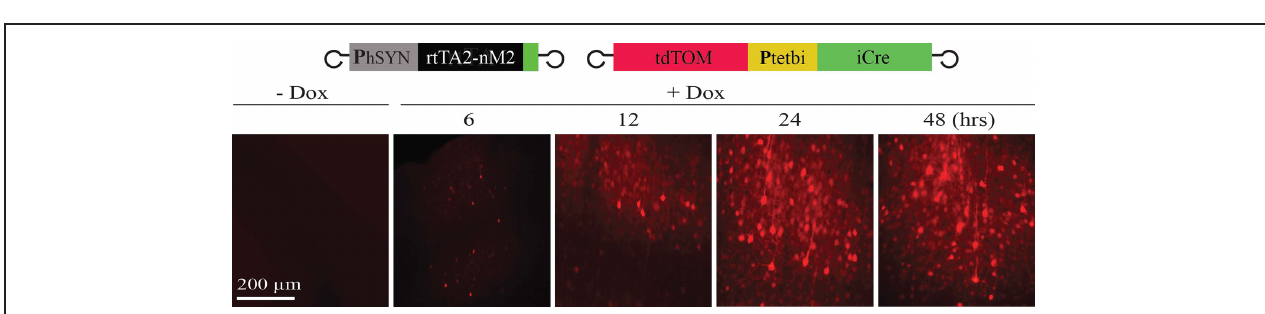
(right; merged image). (B) Expression under the control of P tet bi-GFP-variant vector alone was similar, both with and without Dox, and it compared well with tdTOM expression under the human synapsin